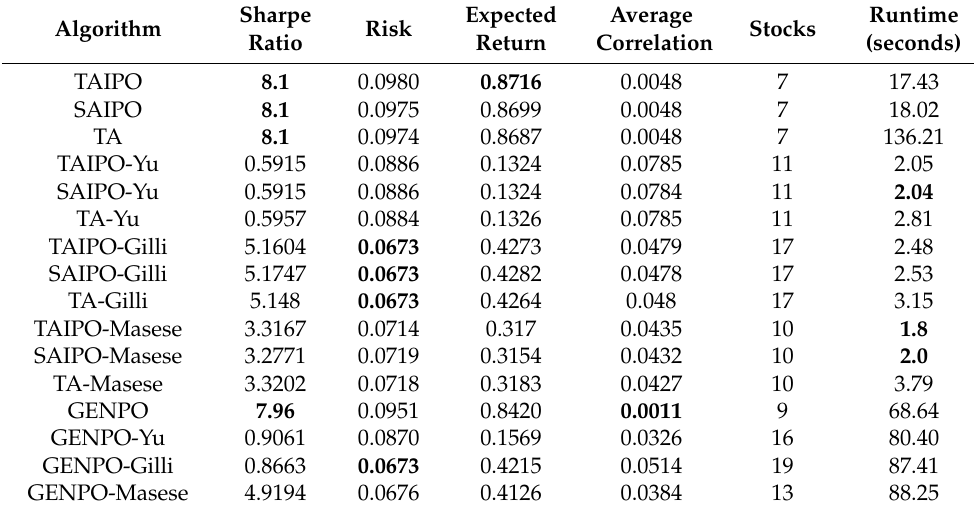
Table 4. Algorithm performance with MARR